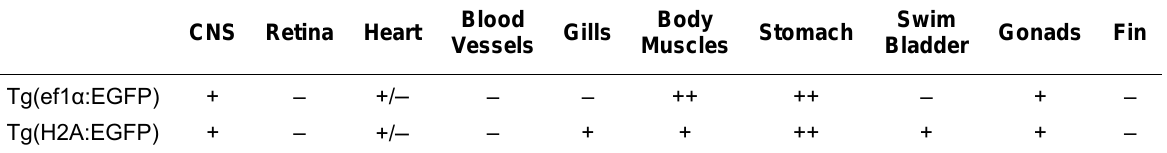
EGFP Expression in Adult